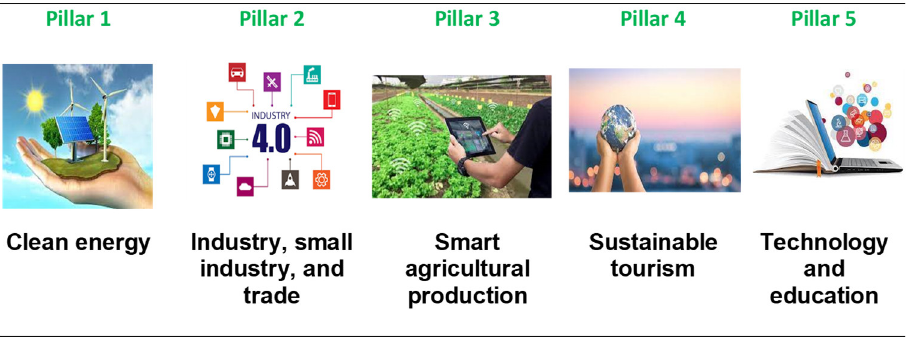
Figure 6. Five key pillars for the post-lignite era in Western Macedonia, Source: